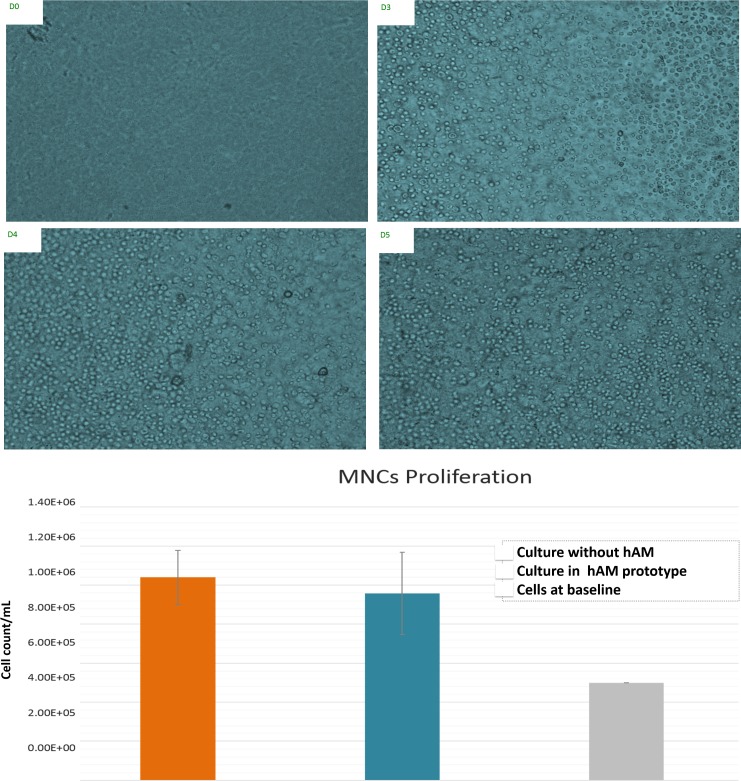
Human Umbilical Cord Blood Mononuclear Cell (MNCs) Culture.This figure shows progressive proliferation of (MNCs) obtained from the umbilical cord blood and cultured on a 6-well plate lined with hAM (Prototype 1). D0 stands first day immediately after culture. D3, 4, 5 represent cell proliferation on days 3, 4 and 5 respectively. The lower panel shows a bar chart for cell proliferation of the MNCs, in another run of experiments, after 7 days of culture in the hAM coated and non-coated plates. The grey bar represents the original number of cells per ml before culture. (Cell images were obtained by an inverted microscope (x40). (Cropping and coloring of image was slightly done for aesthetic purposes without affecting presented data)